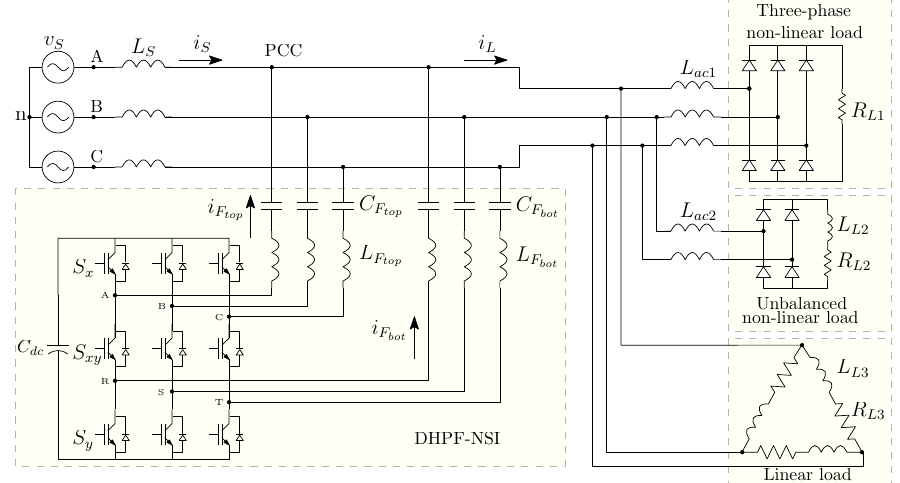
Figure 1. Dual HPF based on the NSI (DHPF-NSI) connected to a three-phase electrical